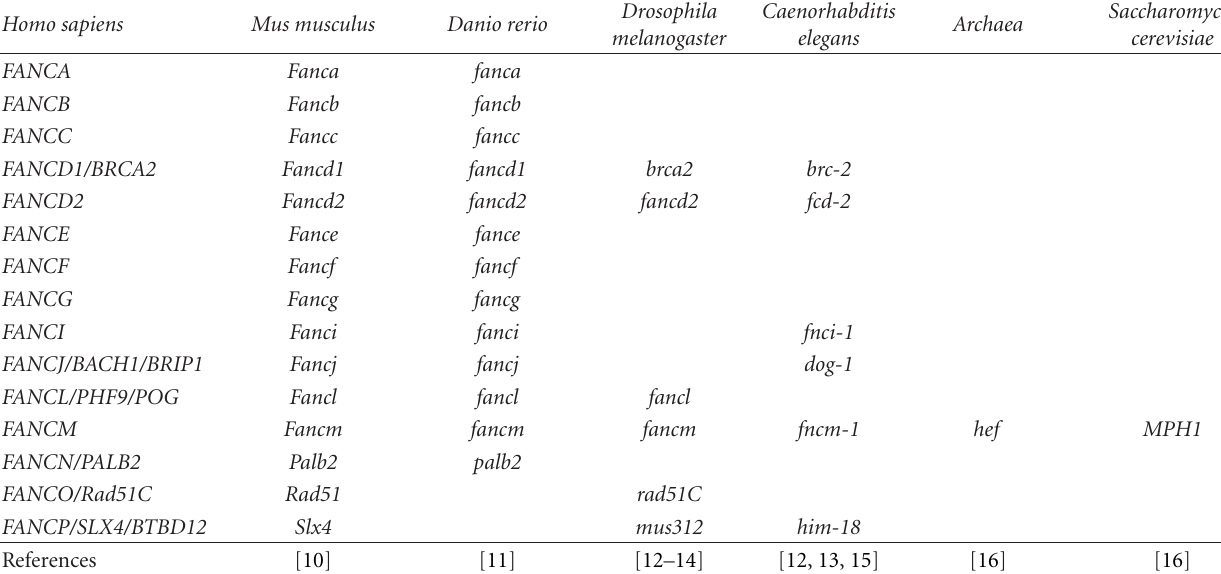
Table 1: Members of the FA signaling pathway found in di ff erent